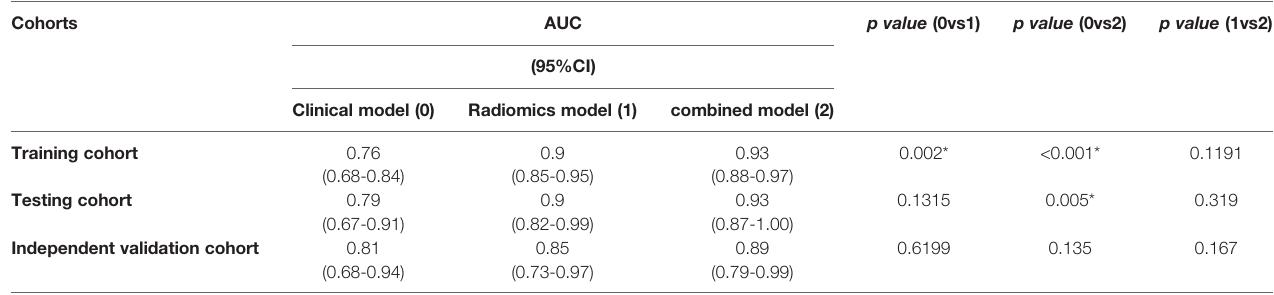
TABLE 2 | Pairwise comparisons of AUCs of the clinical model, radiomics model, and combined model.